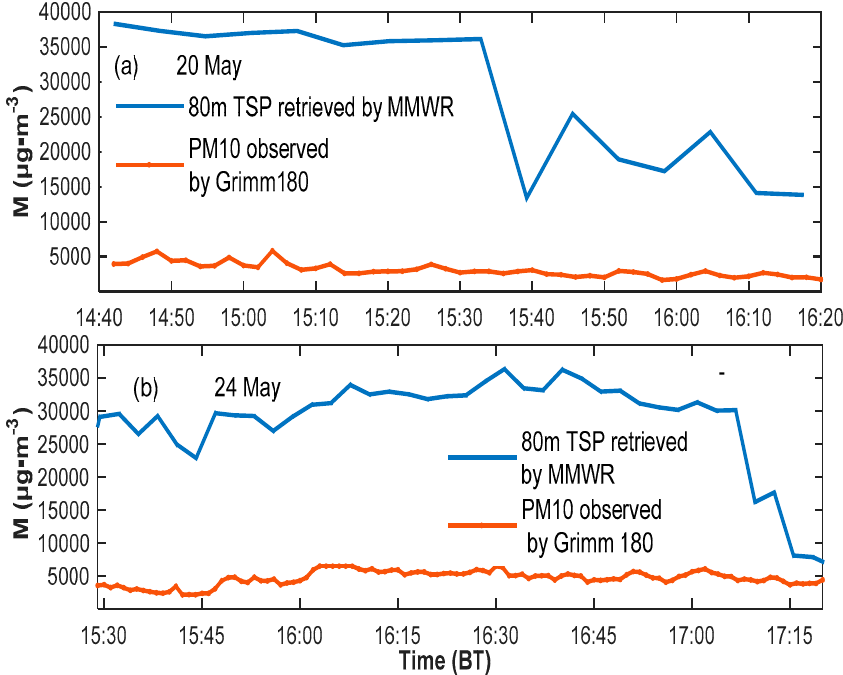
Figure 10. The temporal variation of the 80m height dust mass concentration retrieved from millimeter wave radar (MMWR) data and the temporal variation of the PM10 from Grimm180. ( a ) 20 May, ( b ) 24 May.